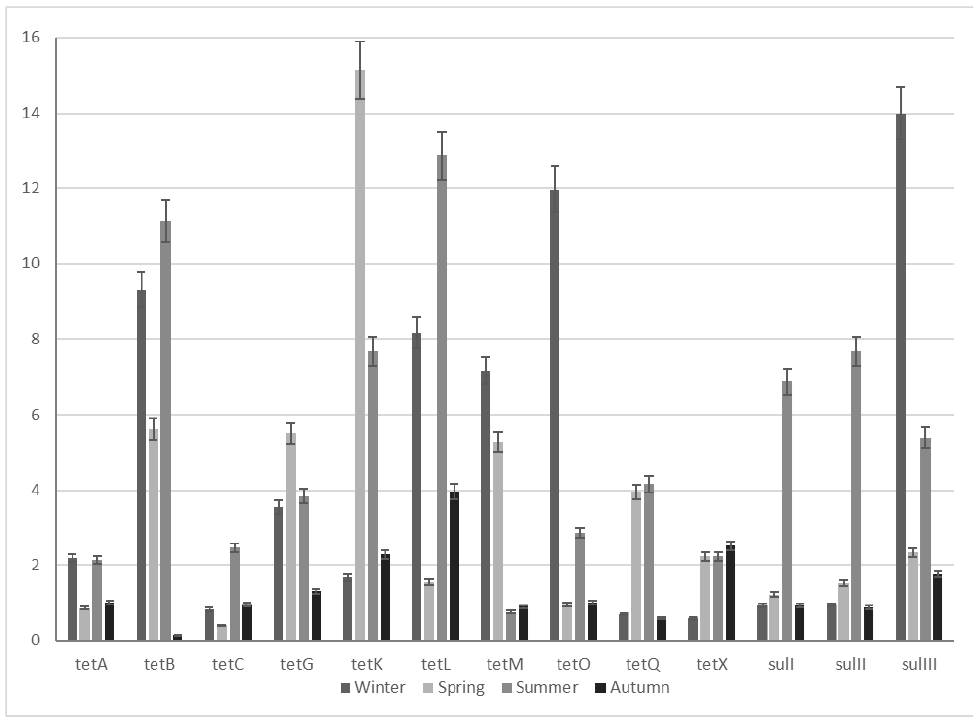
Figure 1. Enrichment of selected ARGs in the WWTP1 samples.